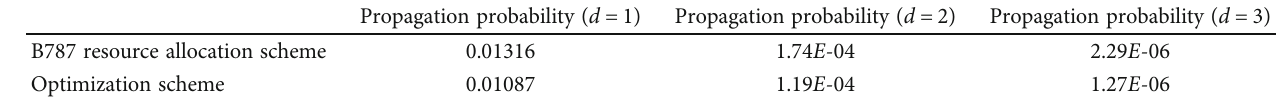
Table 7: Average probability of fault propagation paths for di ff erent allocation